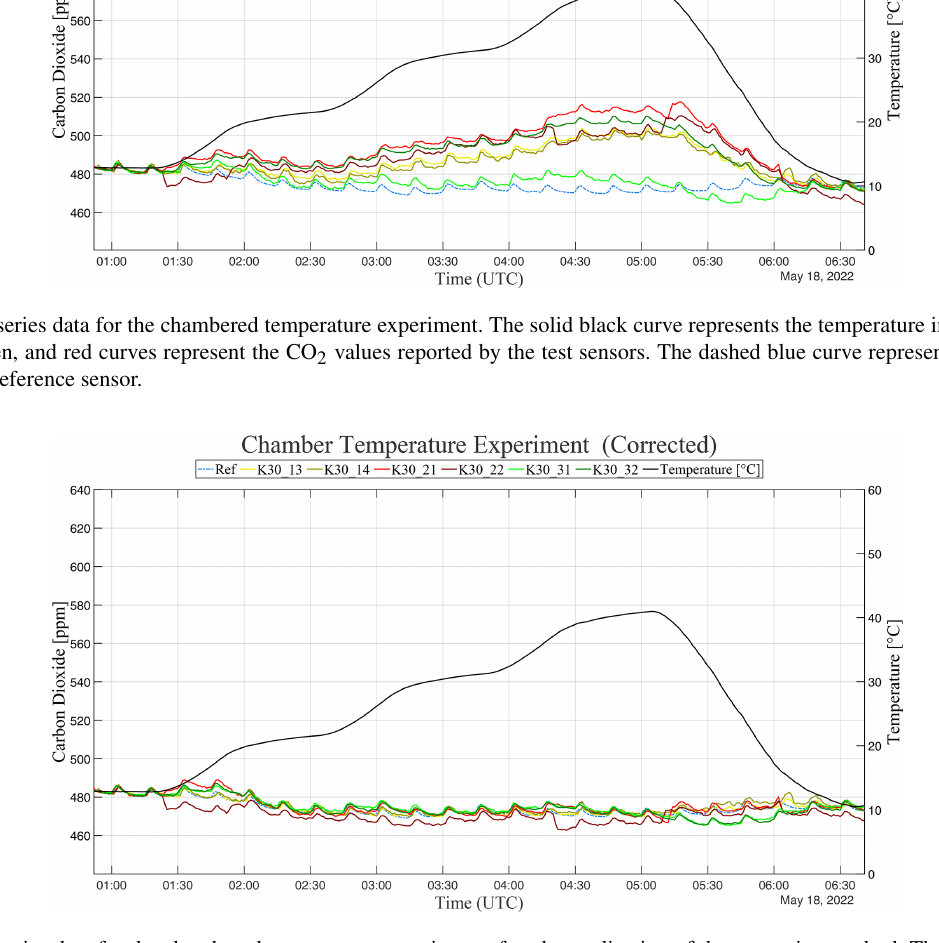
Figure 6. Time-series data for the chambered temperature experiment after the application of the correction method. The solid black curve represents the temperature inside the chamber. The yellow, green, and red curves represent the CO 2 values reported by the test sensors. The dashed blue curve represents the CO 2 values reported by the reference